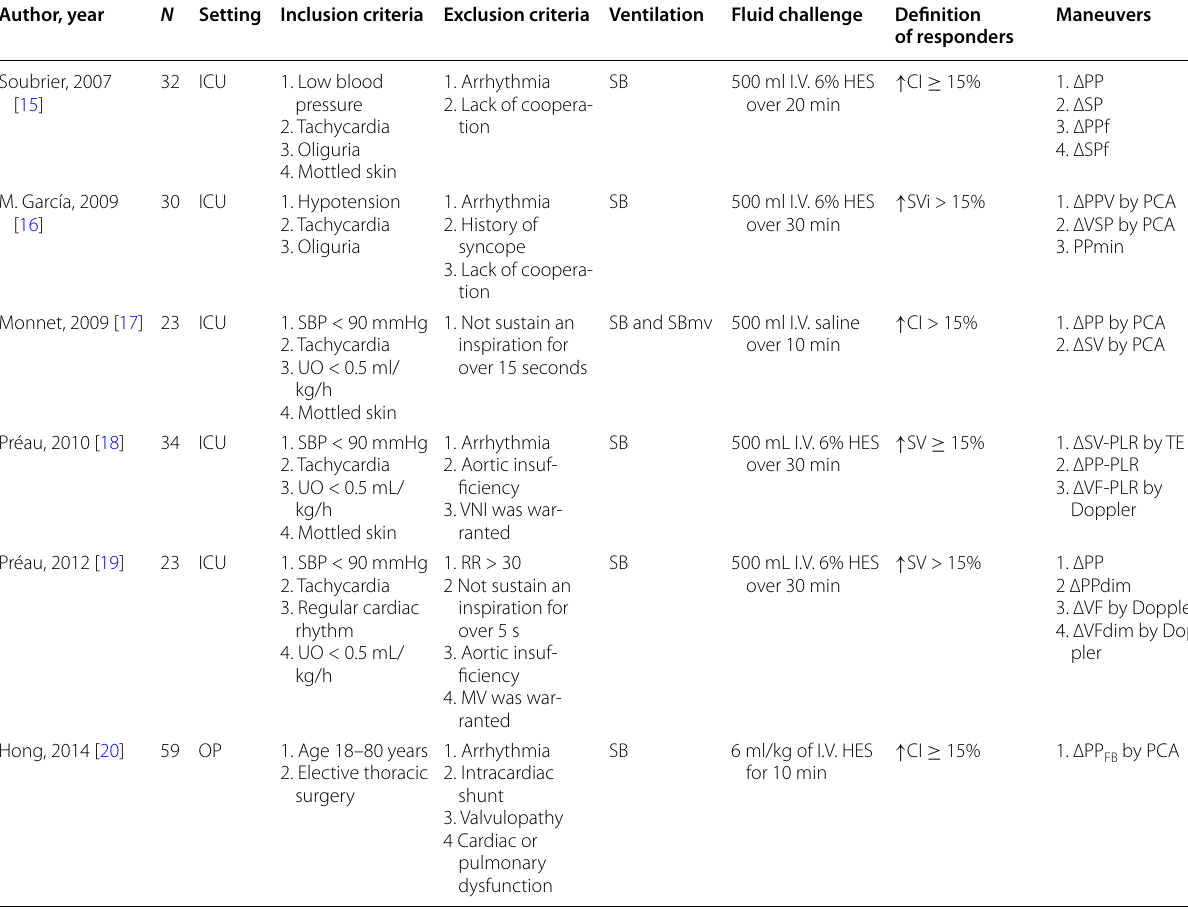
Table 1 Characteristics of included studies addressing pulse pressure variation for fluid responsiveness in spontaneously breathing